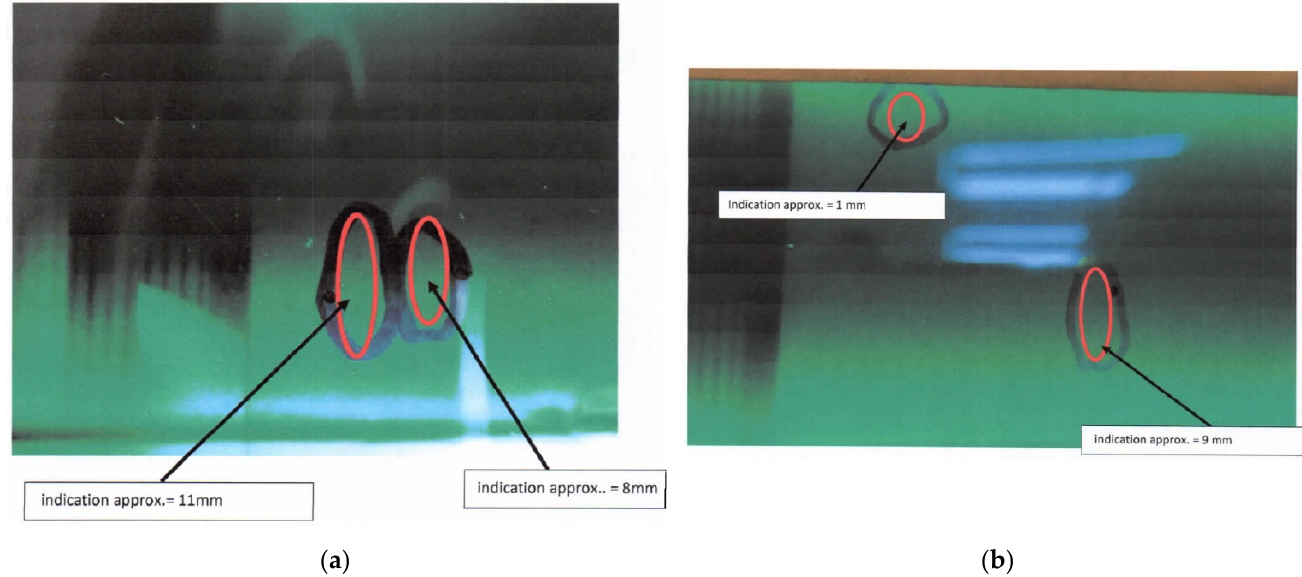
Figure 5 . Discontinuity detection using the RT method. ( a ) RH engine mounting (RT). ( b ) LH engine mounting (RT).